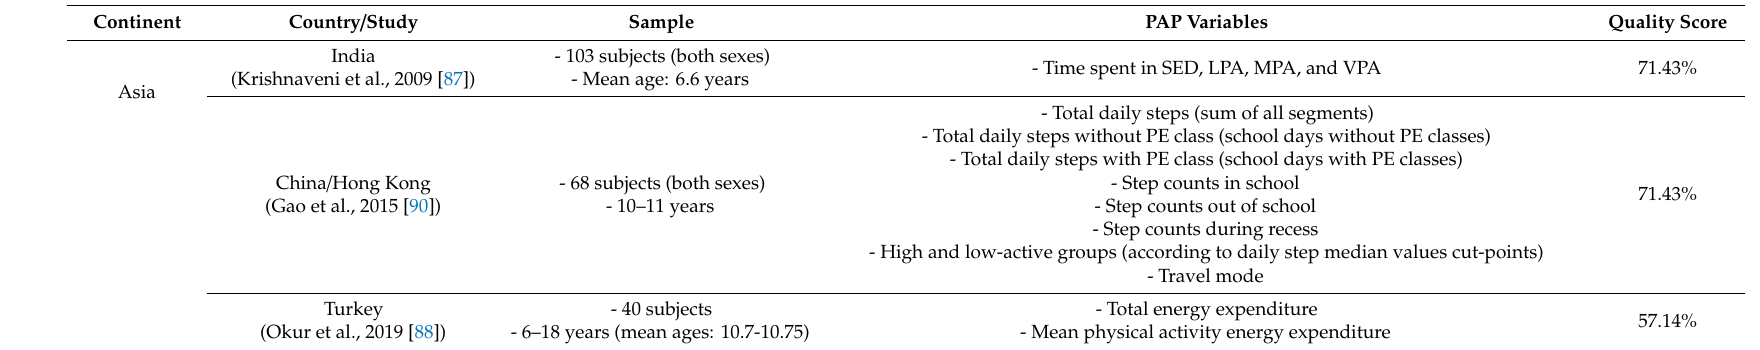
Table 6. Summary of the studies that used combined instruments to assess